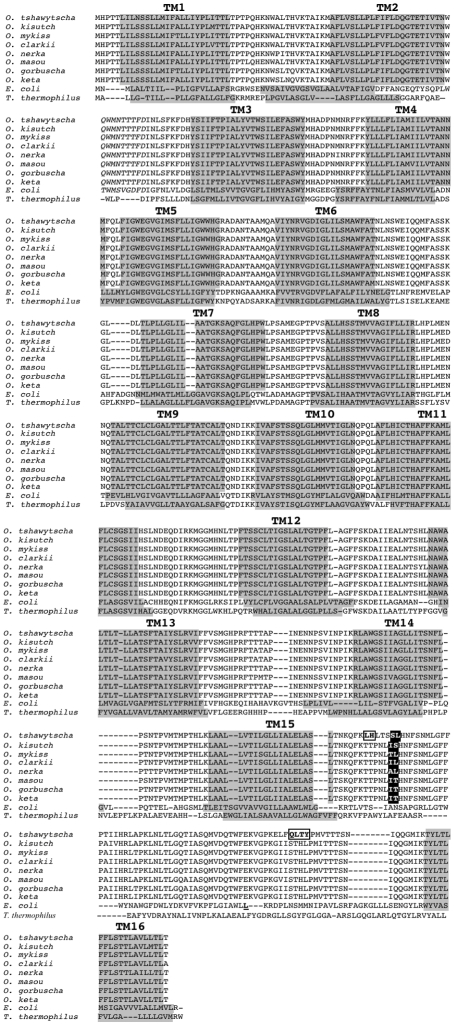
Sequence alignment and secondary structure prediction of the ND5 gene for eight species of Oncorhynchus, the NuoL gene for E. coli and the Nqo12 gene from T. thermophilus.The amino acids in white bold and black background are predicted to be under long-term positive selection in eight species of Oncorhynchus (long-term selection). The amino acids in boxes were determined to have been under positive selection only in O. tshawytscha (episodic selection). Transmembrane domains are shown in bold lettering above gray background-colored amino acids.